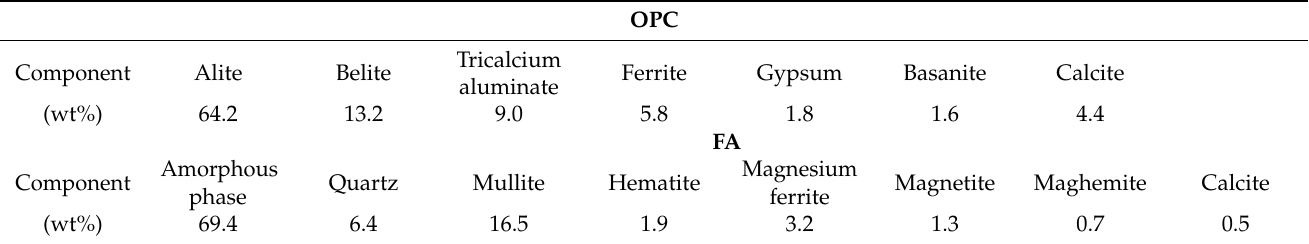
Table 2. OPC and FA quantitative mineralogical composition (wt%).